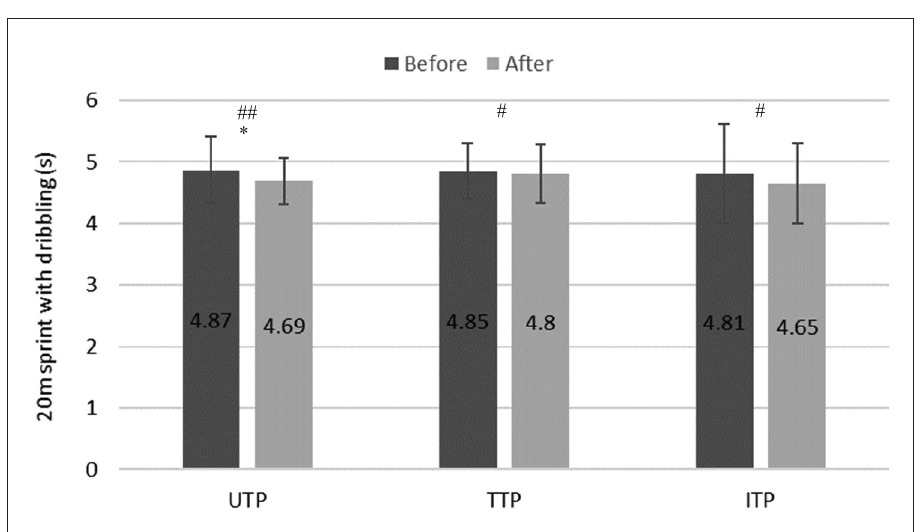
Figure 7. Indicators of 20